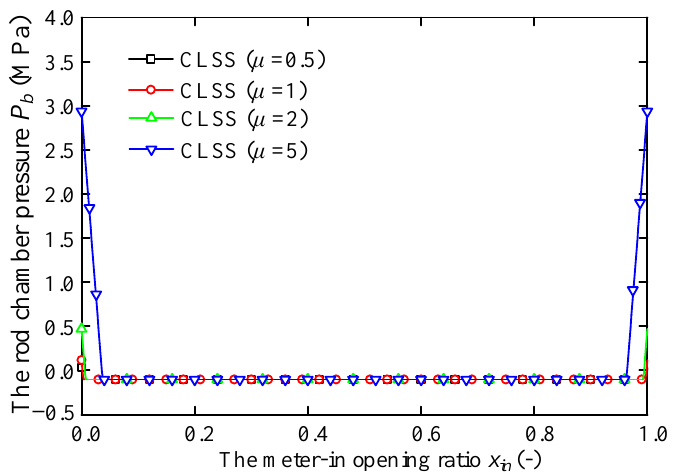
Figure 19. The rod chamber pressure P b of CLSS with retraction working mode.